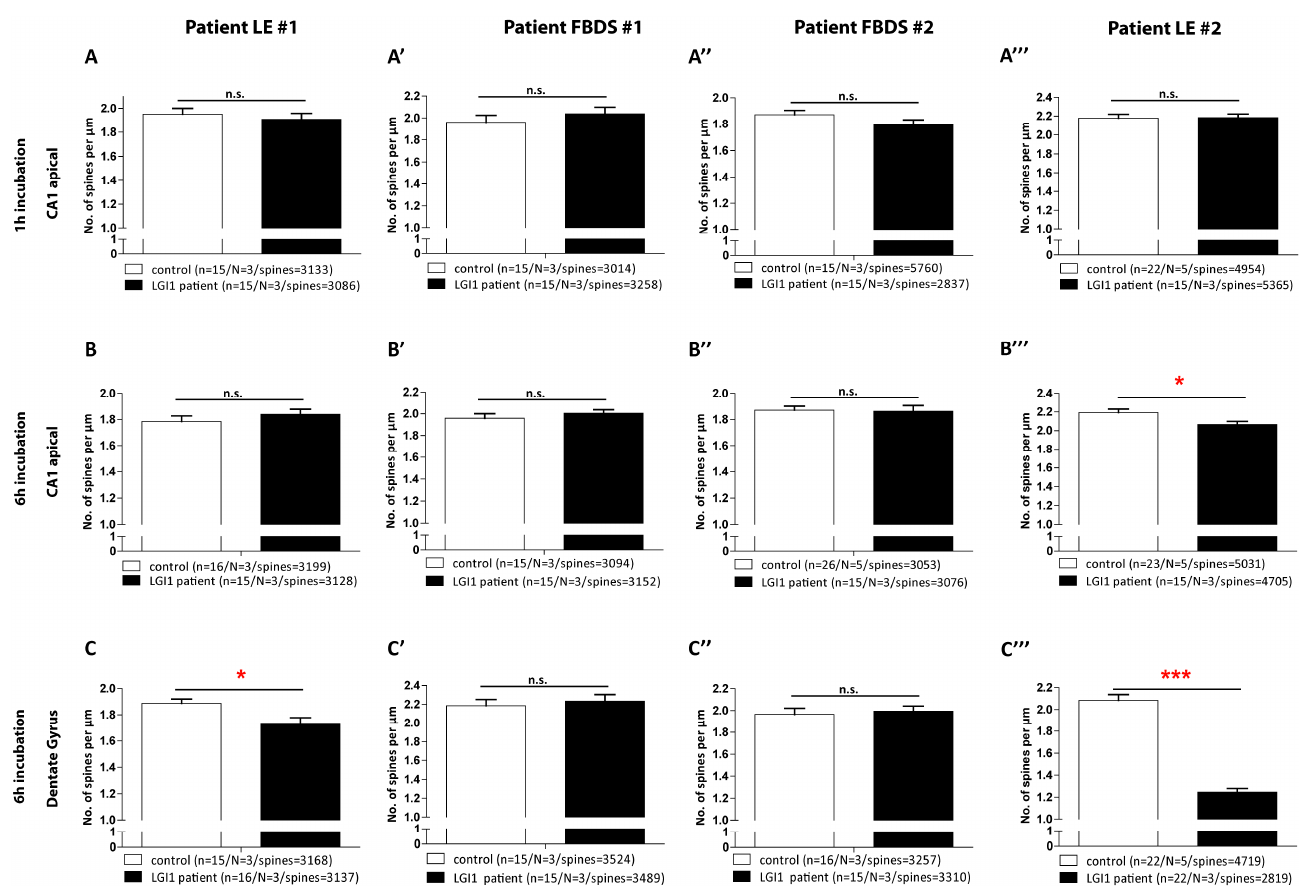
Figure 4. Quantified spine density after short and long ab application in CA1 and DG. Comparable spine density at apical second or third-order dendritic branches of CA1 pyramidal cells after 1 h ( A , A’ , A’’ , A’’’ ) application of individual LGI1 IgG and 6 h ( B , B’ , B’’ , B’’’ ). Only 6 h treatment with IgGs of patient LE#2 reduced spine density ( p = 0.015) ( C , C’ , C’’ , C’’’ ). Spine numbers at granular dendrites after 6 h incubation with individual IgG caused a reduction in spine density for patient LE#1 ( p = 0.014 and #4 p < 0.001). Data presented as mean ± SEM, n = number of dendrites, N = number of animals, spines = number of total spines. Significant results are marked with a red asterisk.* = p < 0.05, *** = p < 0.01, n.s. = not significant